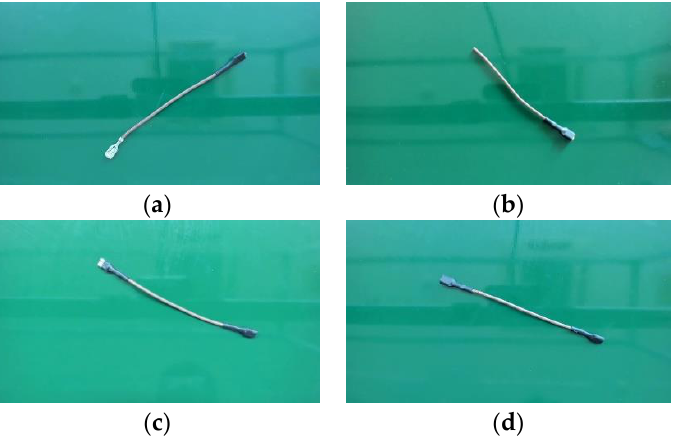
Figure 6. Examples of defective electrical wires. ( a ) Electrical wiring without connector cover; ( b ) Electrical wiring without one connector; ( c ) Electrical wiring with connector partially uncovered; ( d ) Broken electrical wire.